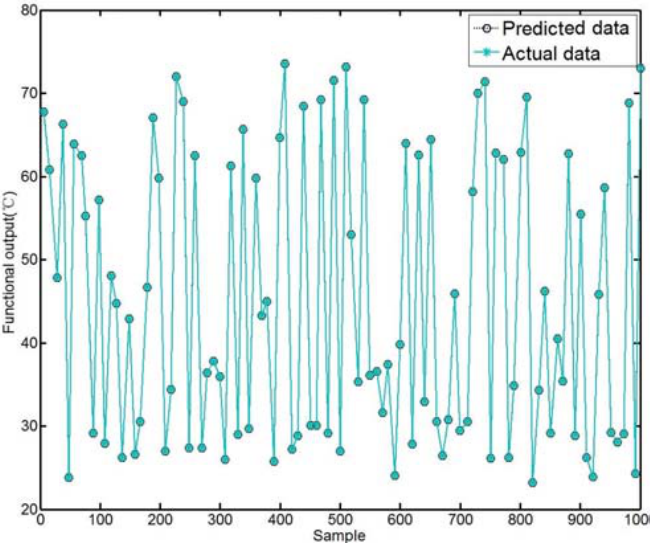
Figure 3. Predicted data of the proposed model compared with the actual data.